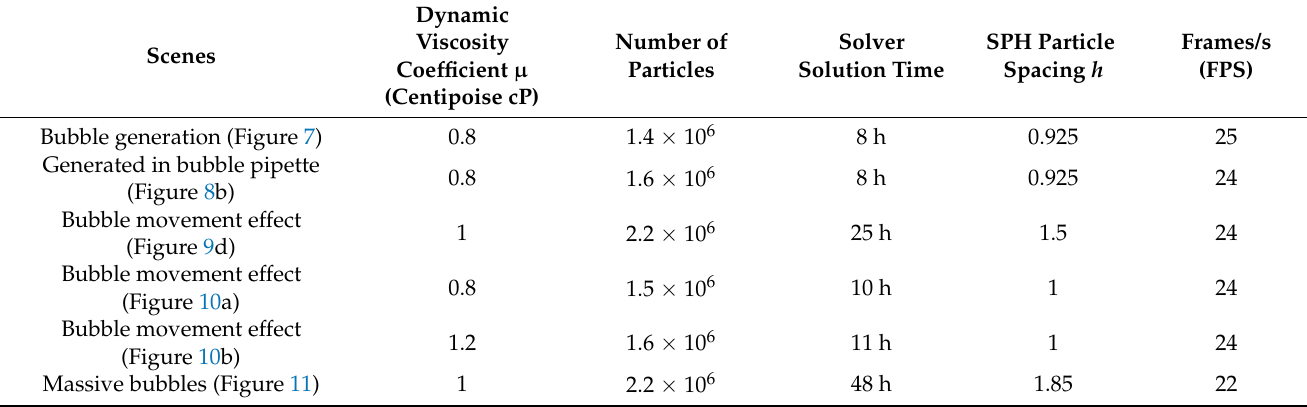
Table 1. Experimental data for different experimental scenarios.